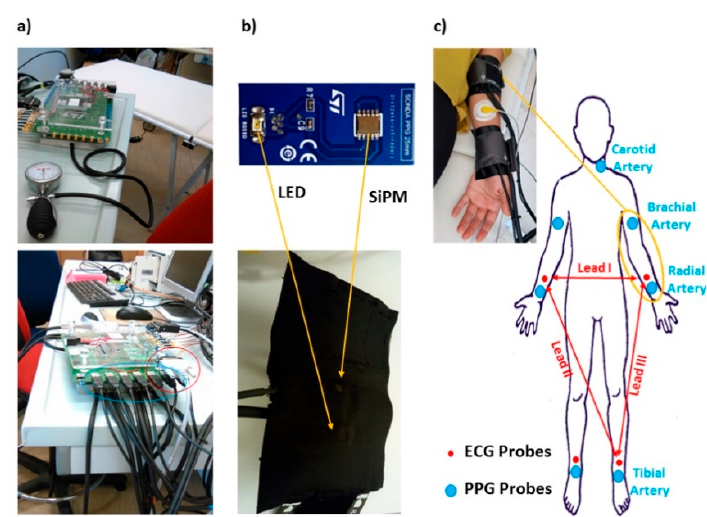
Figure 2. ( a ) Homemade multi-channel Photoplethysmographic (PPG) and Electrocardiographic (ECG) system; ( b ) PPG probe composed by a light emitting diode at 940 nm of wavelength and a silicon photomultiplier (SiPM) detector; ( c ) example of PPG probes and ECG electrode placement on a subject arm and schematic locations of the PPG probes and ECG electrodes on a body template.